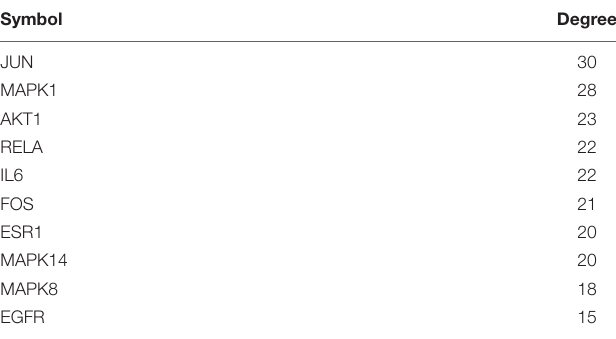
TABLE 3 | Analysis of PPI network results.